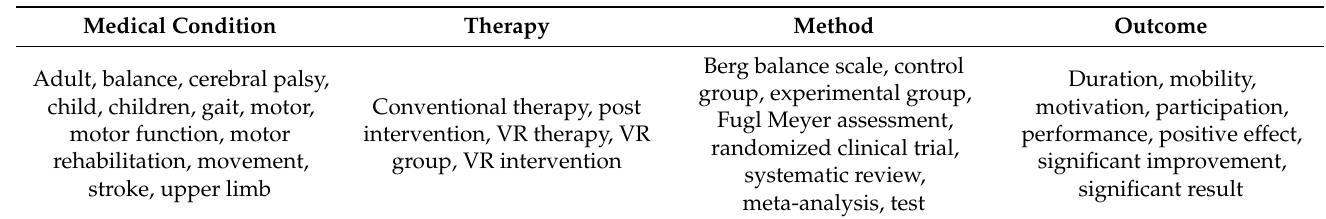
Table 5. Categorized terms associated with diseases of the nervous system (DNS) from Figure 6 (devised by the